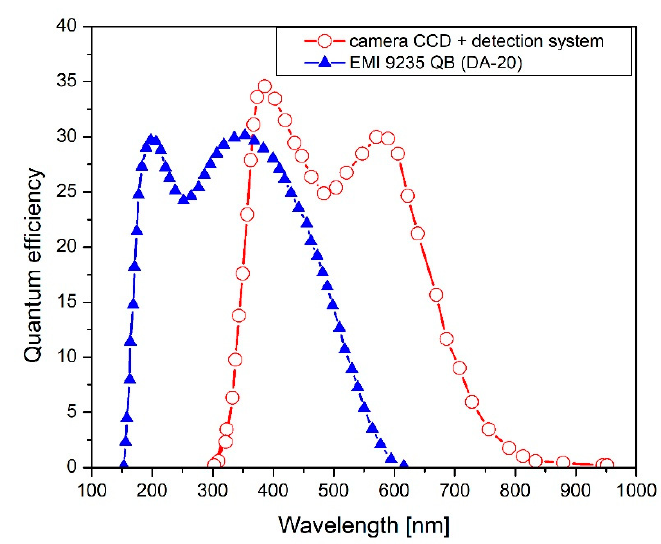
Figure 2. Comparison of spectral characteristics of the applied detection system: camera CCD (with lenses)—red circle, and photomultiplier EMI 9235 QB used in the DA-20 TL reader—blue triangle.